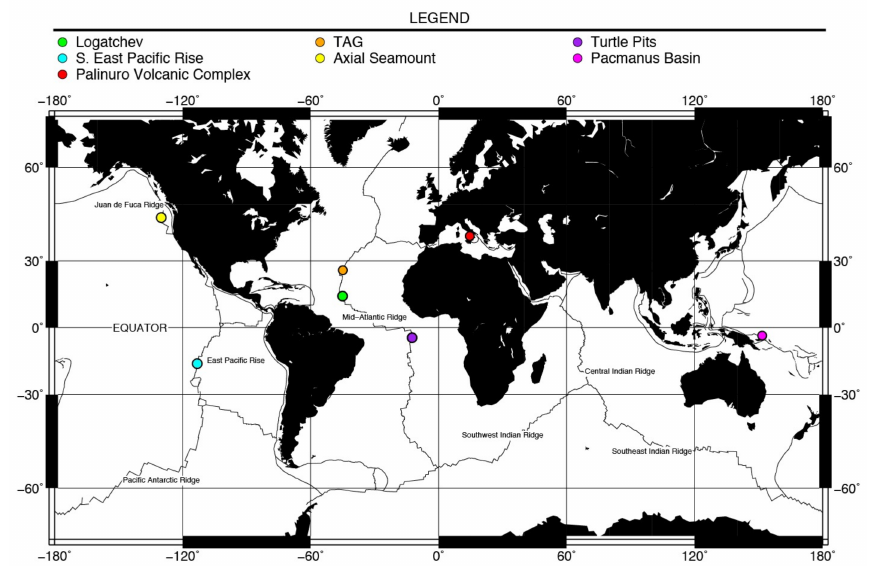
Figure 1. Coloured circles represent the global distribution of the hydrothermal fields and seafloor samples investigated in this study including ASHES, located at Axial Volcano on the Juan de Fuca Ridge, 16 ◦ 43’S hydrothermal field along the South East Pacific Rise, active Trans-Atlantic Geotraverse (TAG) mound, Logatchev-1, Turtle Pits, Pacmanus and Palinuro Volcanic Complex